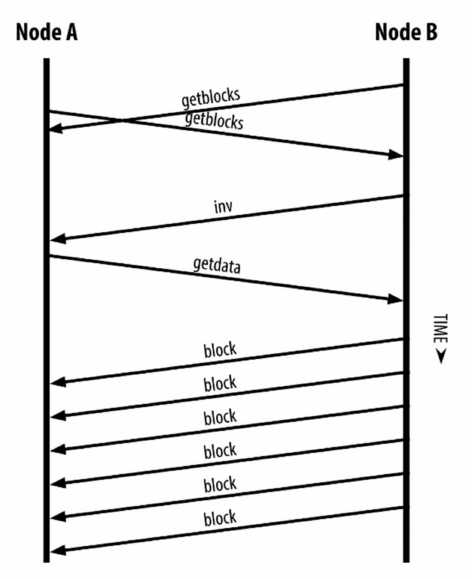
Figure 1. An illustrative example of node